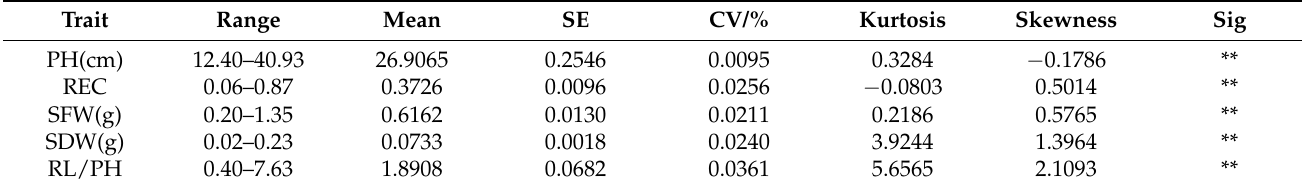
Table 1. Statistical analysis of phenotypic indicators of F 2:3 population (2 ◦ C; 5 d).